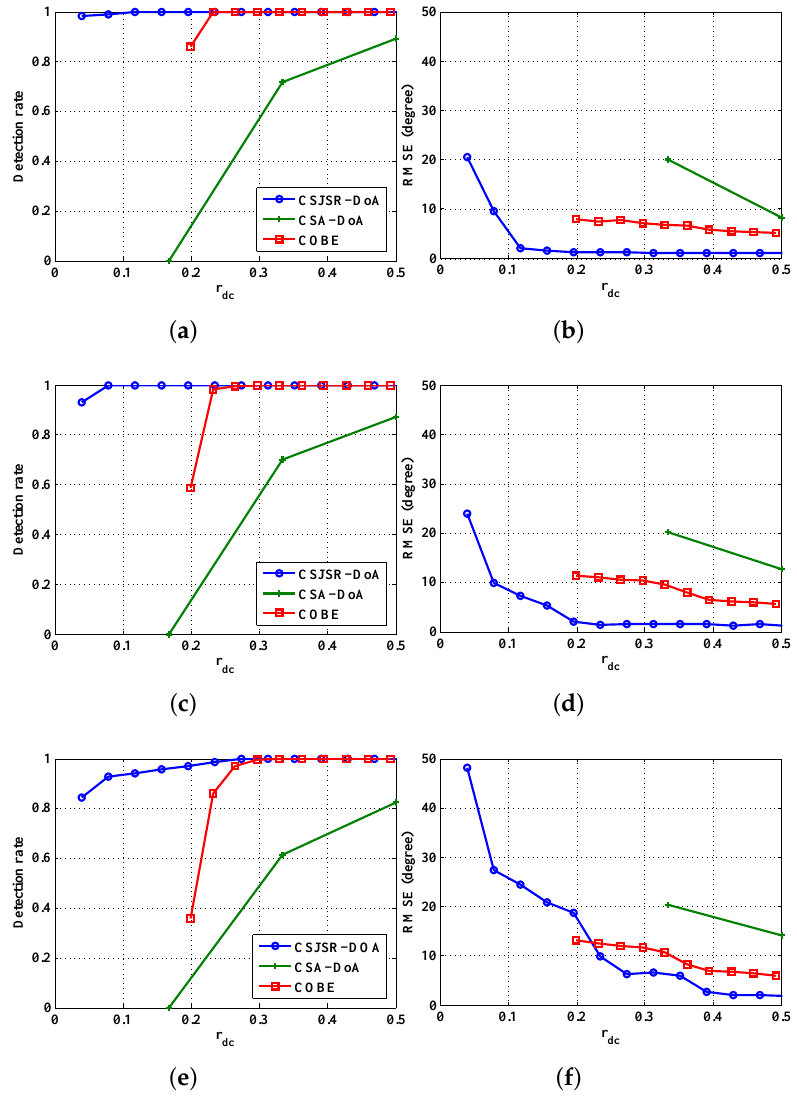
Figure 9. Performance comparison among CS-based methods under the same SNR ratio:( a ) Detection rate with SNR = 10 dB; ( b ) RMSE with SNR = 10 dB; ( c ) Detection rate with SNR = 5 dB;( d ) RMSE with SNR = 5 dB; ( e ) Detection rate with SNR = 0 dB; ( f ) RMSE with SNR = 0